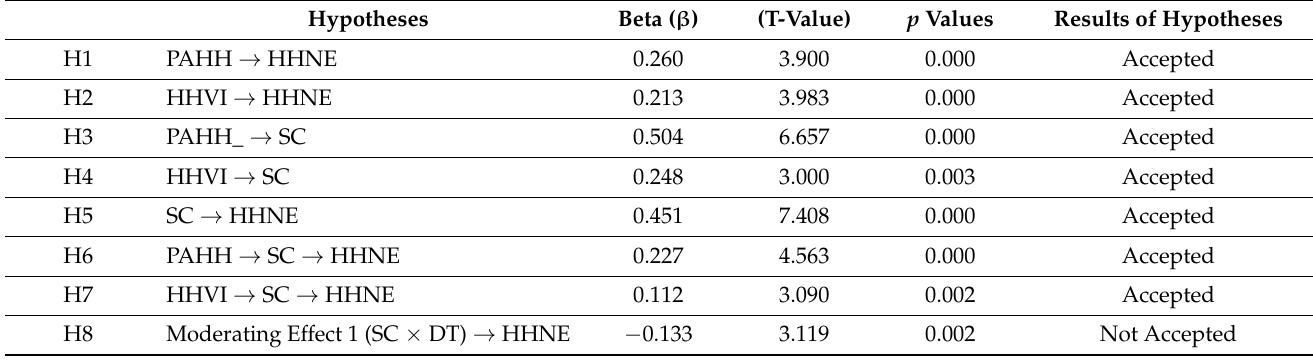
Table 5. The structural model’s